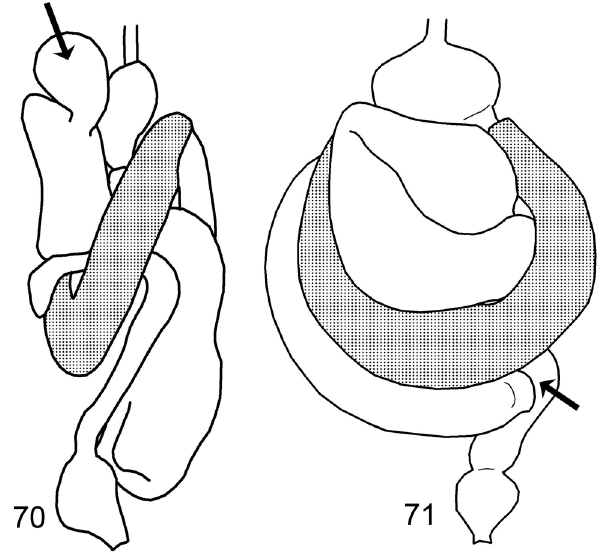
Figs 70–71. Worker gut in situ : 70- Crepititermes verruculosus , right view (arrow: distal P3 diverticulum); 71- Orthognathotermes sp., dorsal view (arrow: P1-P3 connection).